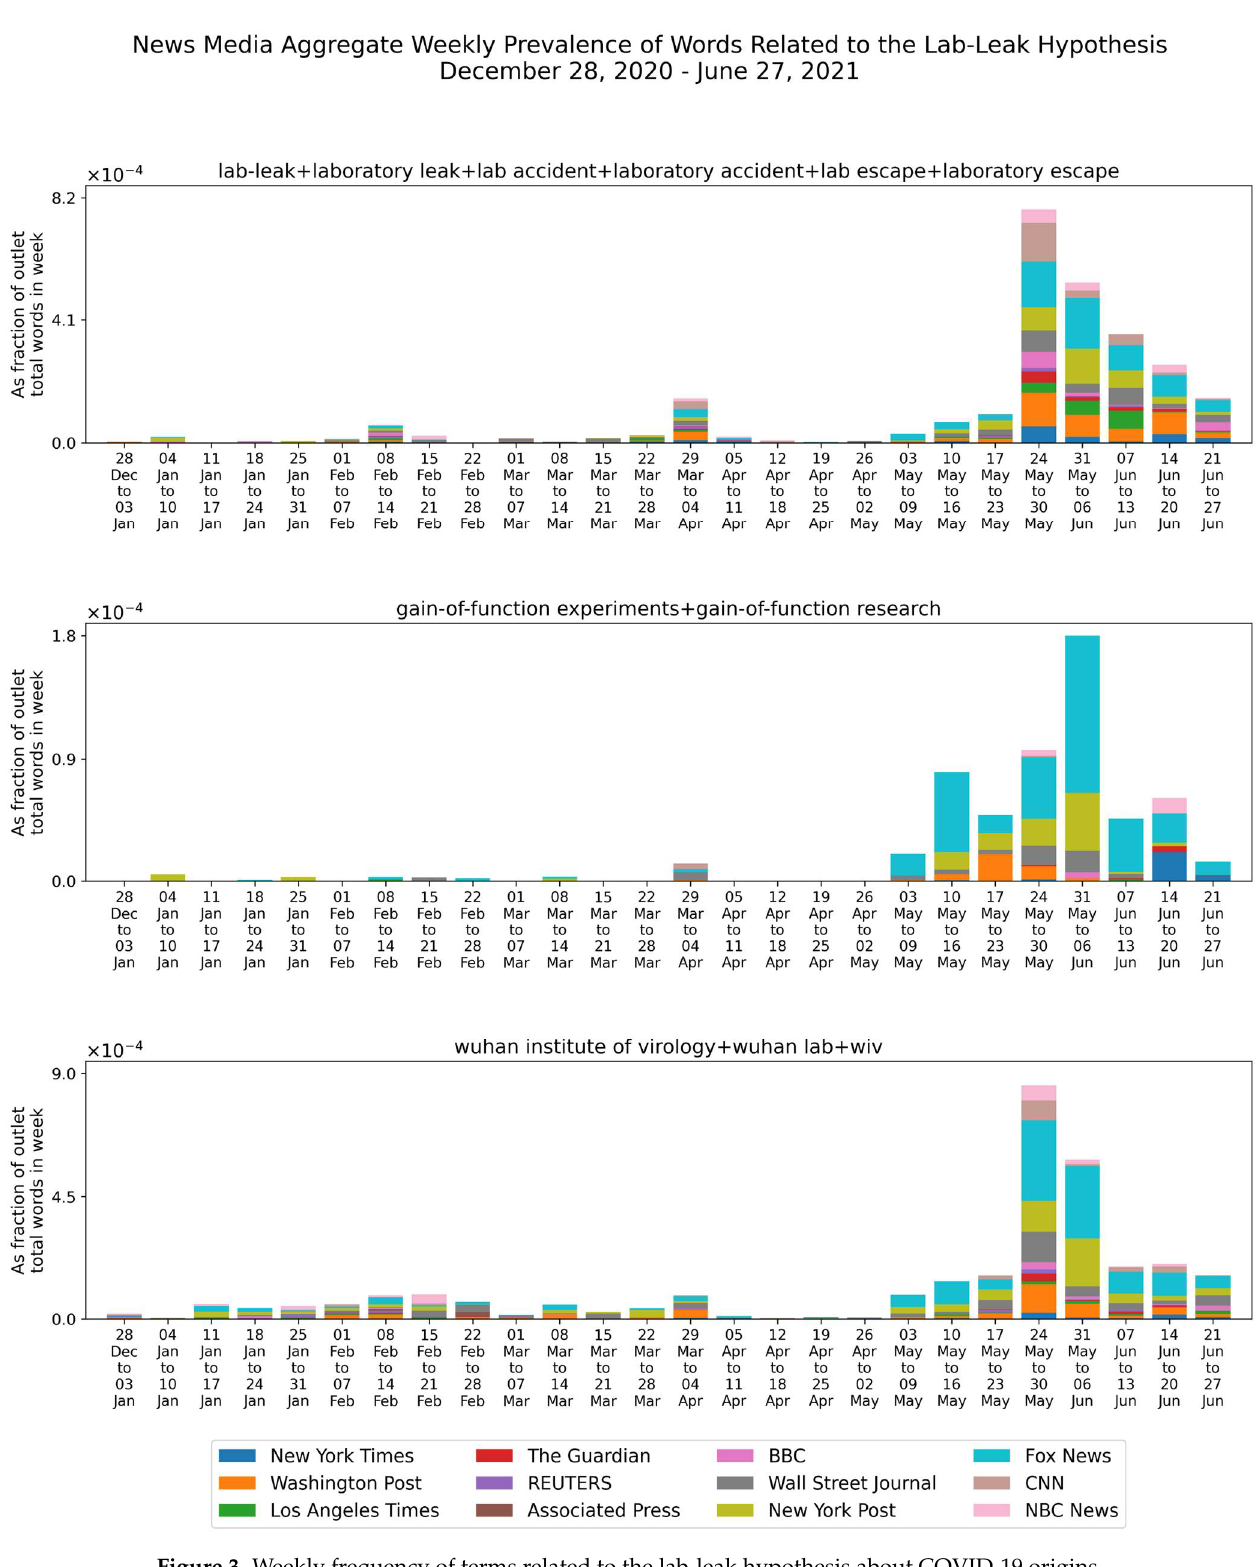
Figure 3. Weekly frequency of terms related to the lab-leak hypothesis about COVID-19 origins. To achieve even higher granularity temporal dynamics of the lab-leak hypothesis thematic prevalence in news media, we next analyze daily frequency counts of target